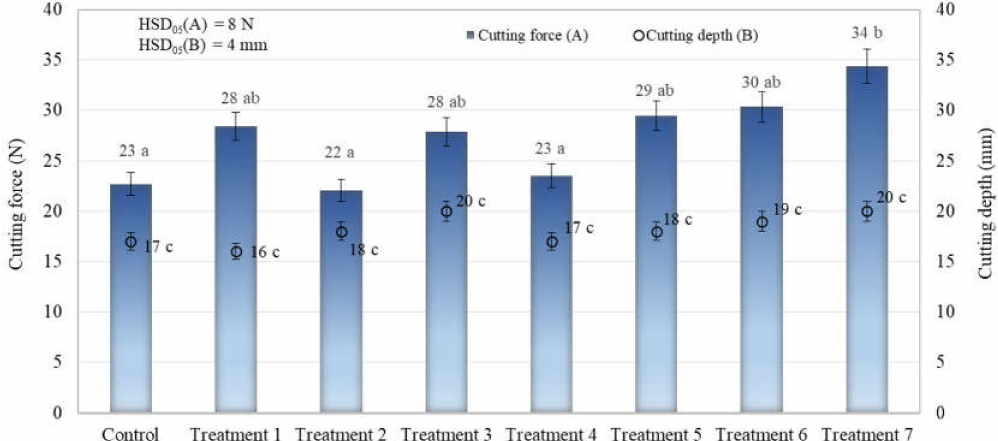
Figure 7. The impact of different biopreparations on winter wheat cutting force and cutting depth: Treatment 1—composition of the biopreparation No. 1; Treatment 2—No. 1 and No. 2 mixture; Treatment 3—composition of the biopreparation No. 2; Treatment 4—No. 1 and No. 3 mixture; Treatment 5—composition of the biopreparation No. 4; Treatment 6—No. 1 and No. 4 mixture; Treatment 7—composition of the biopreparation No. 3. The same letters indicate no significant